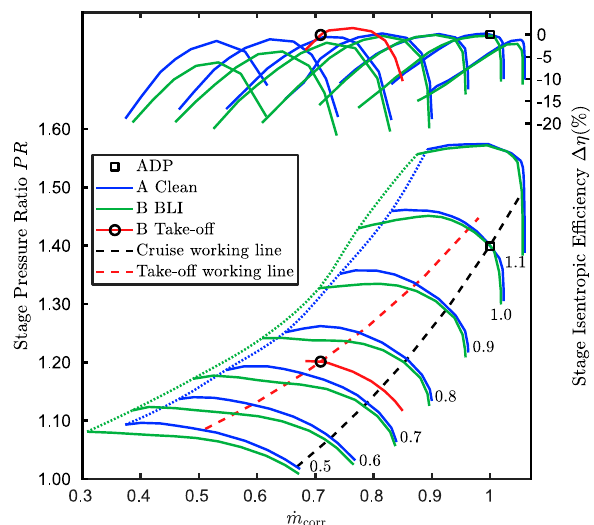
Figure 13. Comparison of cruise maps for Fan A and Fan B.